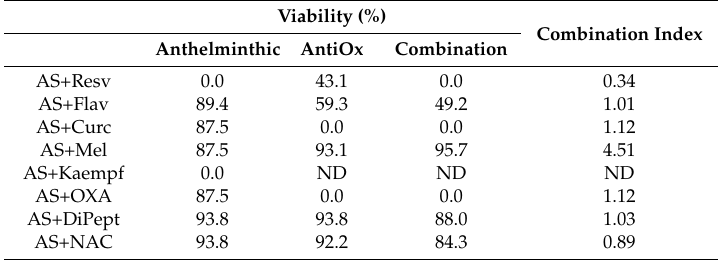
Table 6. Viability (%) and cooperative index for NTS exposed to AS, antioxidant and the combination. Viability